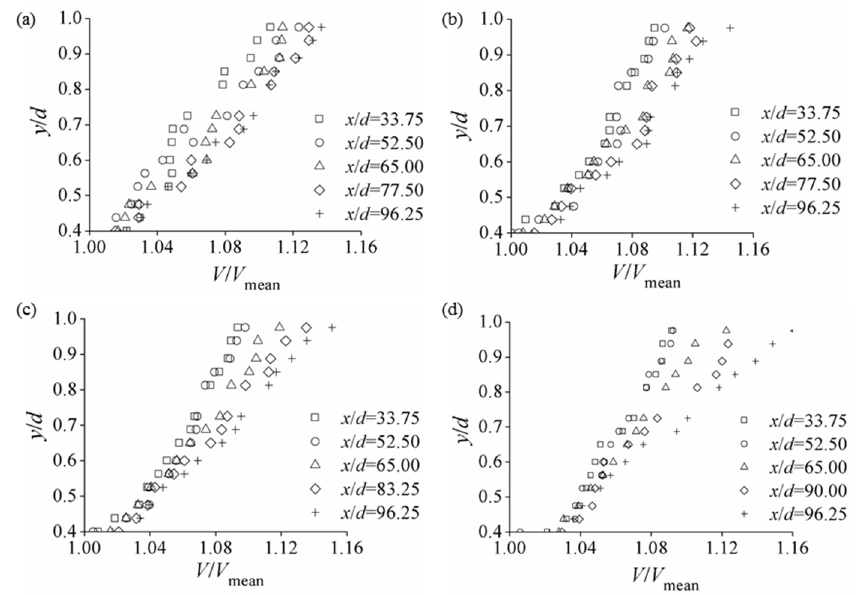
Figure 8. Near-free surface distribution of time mean velocity: ( a ) Q = 0.18 m 3 /s; ( b ) Q = 0.19 m 3 /s; ( c ) Q = 0.20 m 3 /s; ( d ) Q = 0.21 m 3 /s.